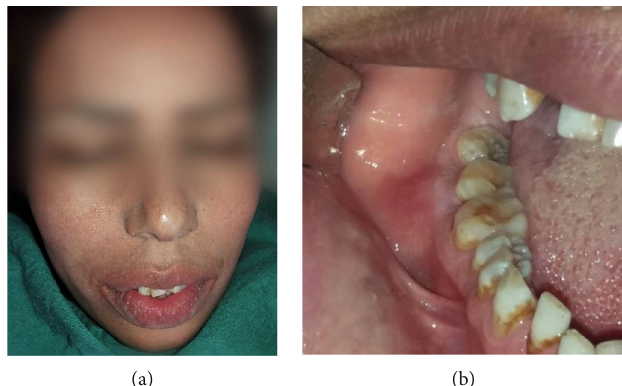
Figure 1: (a) Extraoral photograph. (b) Vestibular tumefaction regarding the 47; the recovering mucosa appears normal.